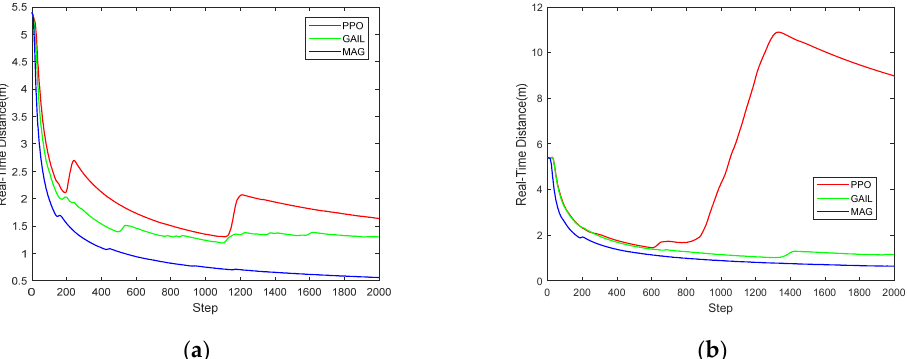
Figure 5. Real-Time distance between the AUV and target training 100,000 times in Scenes 1 and 2: ( a ) Scene 1 and ( b ) Scene 2.